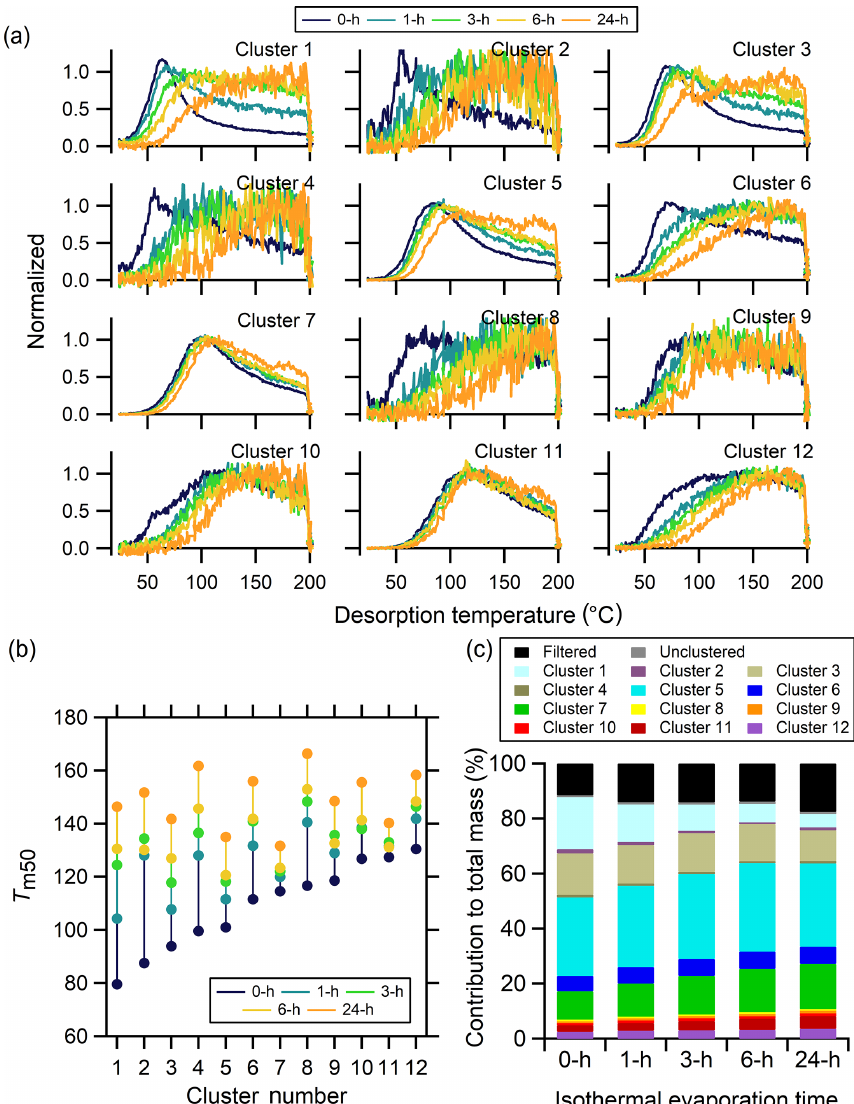
Figure 12. Single-clustering results for α -pinene + O 3 SOA for different isothermal evaporation times. (a) Comparison of the normalized, weighted average thermograms of the 12 clusters for the 0h wait (navy), 1h wait (blue), 3h wait (green), 6h wait (yellow), and 24h wait (orange) experiments. Note that the absolute signals of all of the clusters decrease with evaporation but to varying extents (Fig.